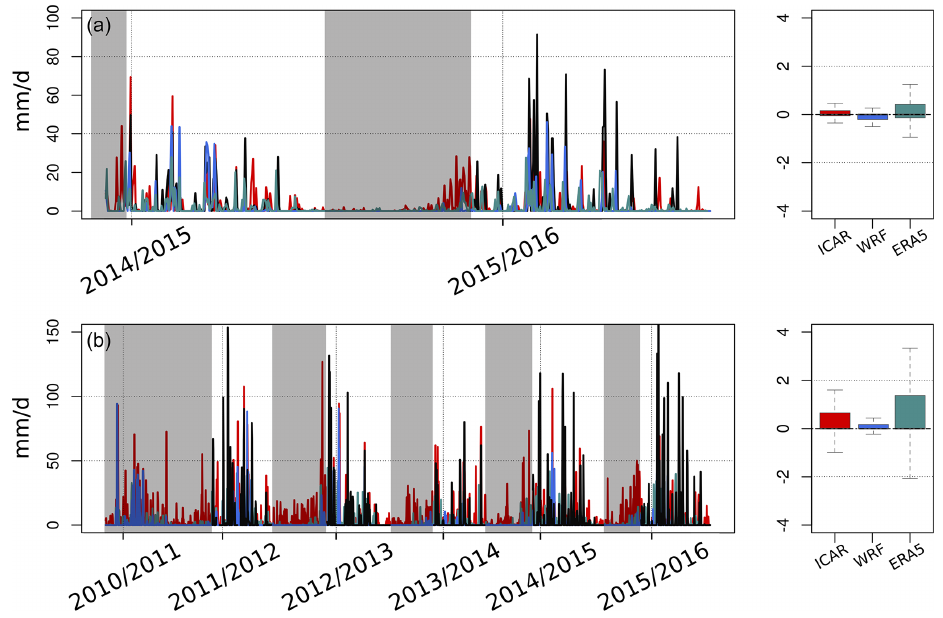
Figure 4. ERA5 (green), WRF (blue), ICAR (red) and AWS (black) daily precipitation data. The box plots represent the distribution of the errors, and the gray shadows represent the data gaps in the